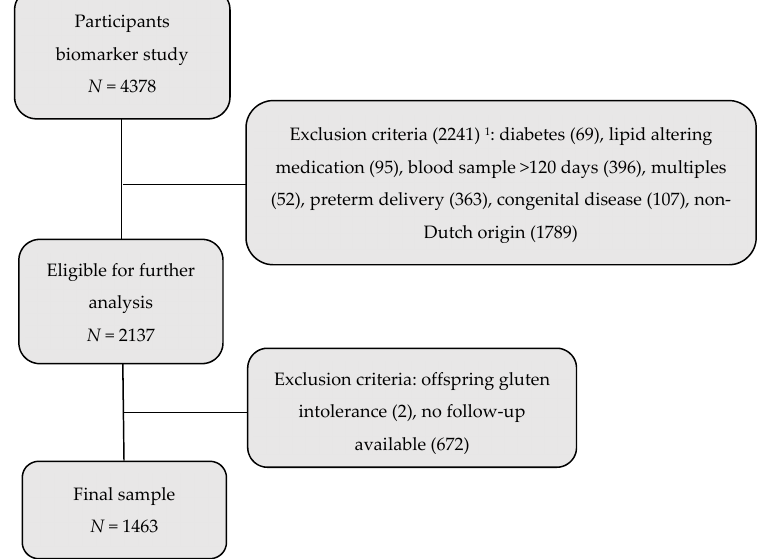
Figure 1. Flowchart presenting exclusion criteria and study population. 1 Numbers sum to more than 2241, as sometimes more than one exclusion criterion was present.